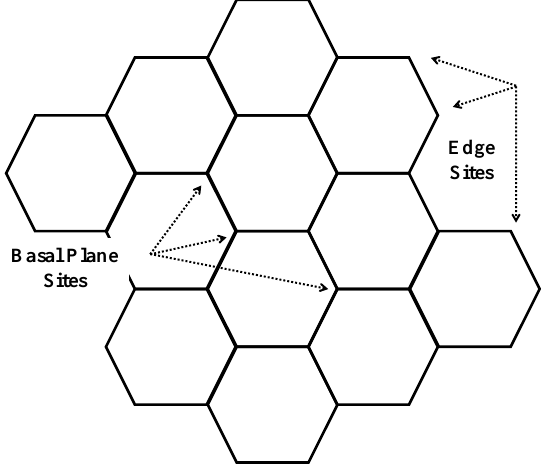
Figure 11. A schematic illustrating edge and basal plane carbon sites.